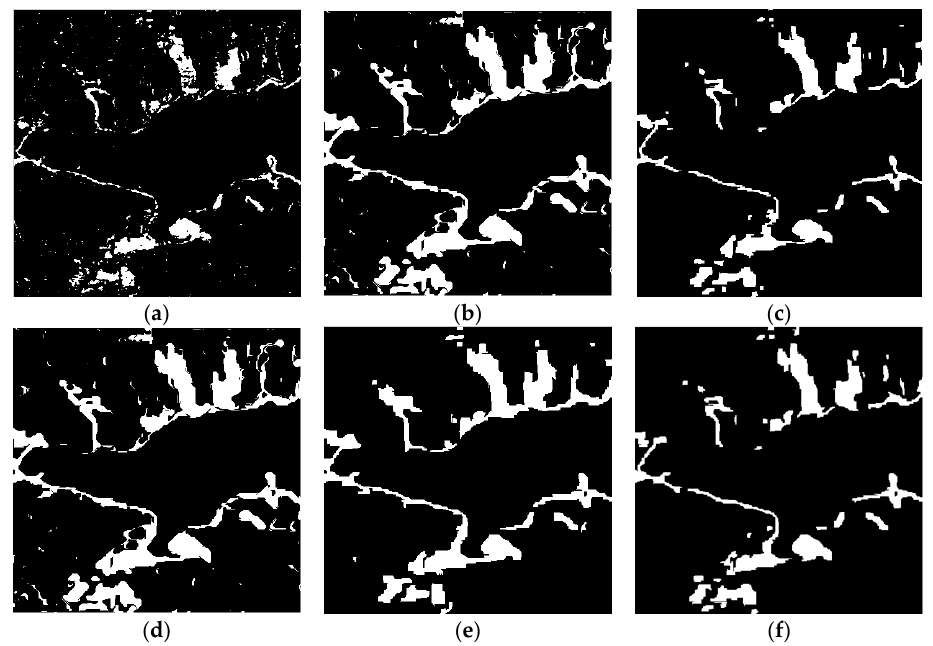
Figure 9. Change detection results of the different algorithms over LiangZi Lake between 2015 and 2016. ( a ) Change detection result using OT_GGMM_pix ( k = 21). ( b ) Change detection result using OT_GGMM_obj ( k = 33). ( c ) Change detection results using OT_GSRM_TDES. ( d ) Change detection results using OT_GSRM_KI. ( e ) Change detection results using OT_GSRM_Kmeans. ( f ) Change detection results using the OT_GSRM_GGMM ( k = 25).